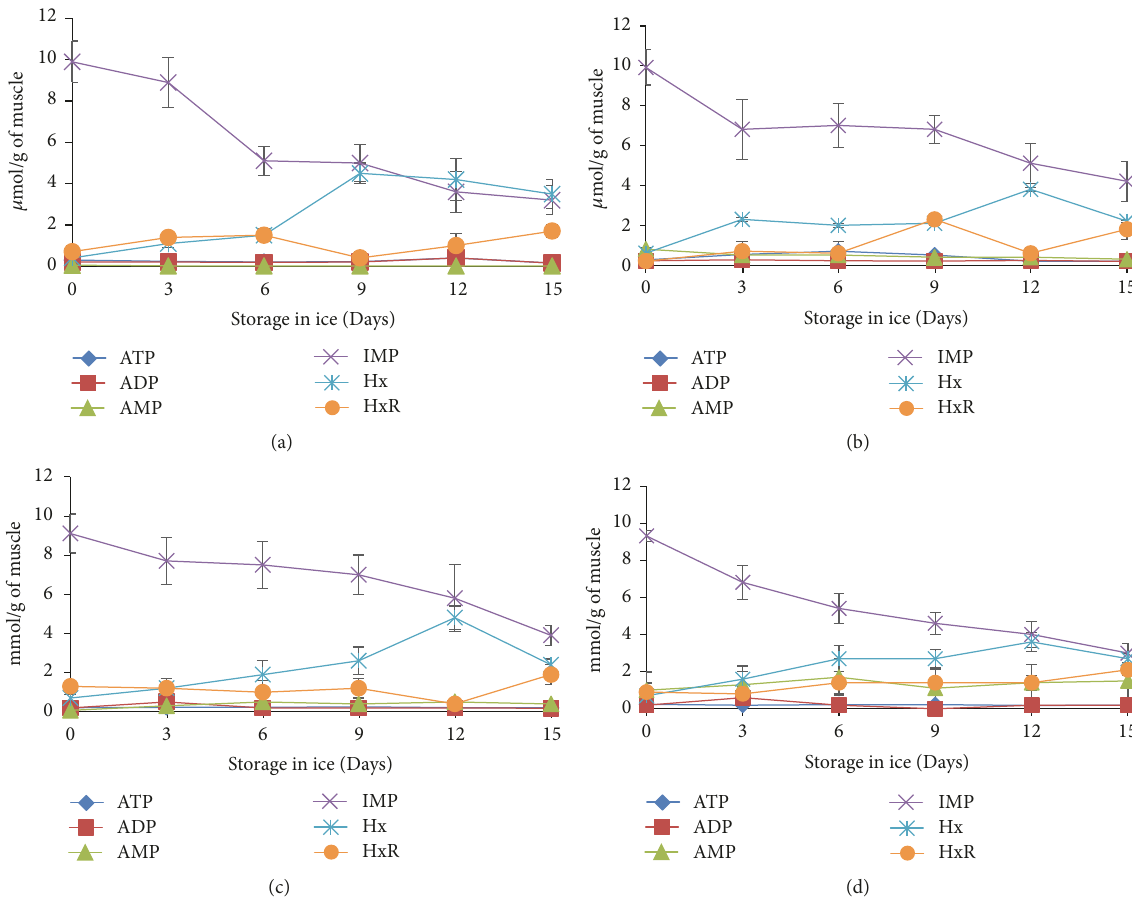
Figure1:ConcentrationofATP,ADP,AMP,IMP,HxR,andHxinfilletsofsierra (Scomberomorussierra) withdifferenttreatments:(a)control, (b) tomato plan extract, (c) chitosan, and (d) tomato plant extract-chitosan, stored during 15 days in ice. The values are the average of 𝑛 = 4 ± the standard deviation. The concentrations of ATP, ADP, and AMP were not affected by the treatments and the storage time on ice ( 𝑝 ≥ 0.05 ), while the concentration of IMP, Hx, and HxR was affected by the treatments and storage time ( 𝑝 < 0.05 ).